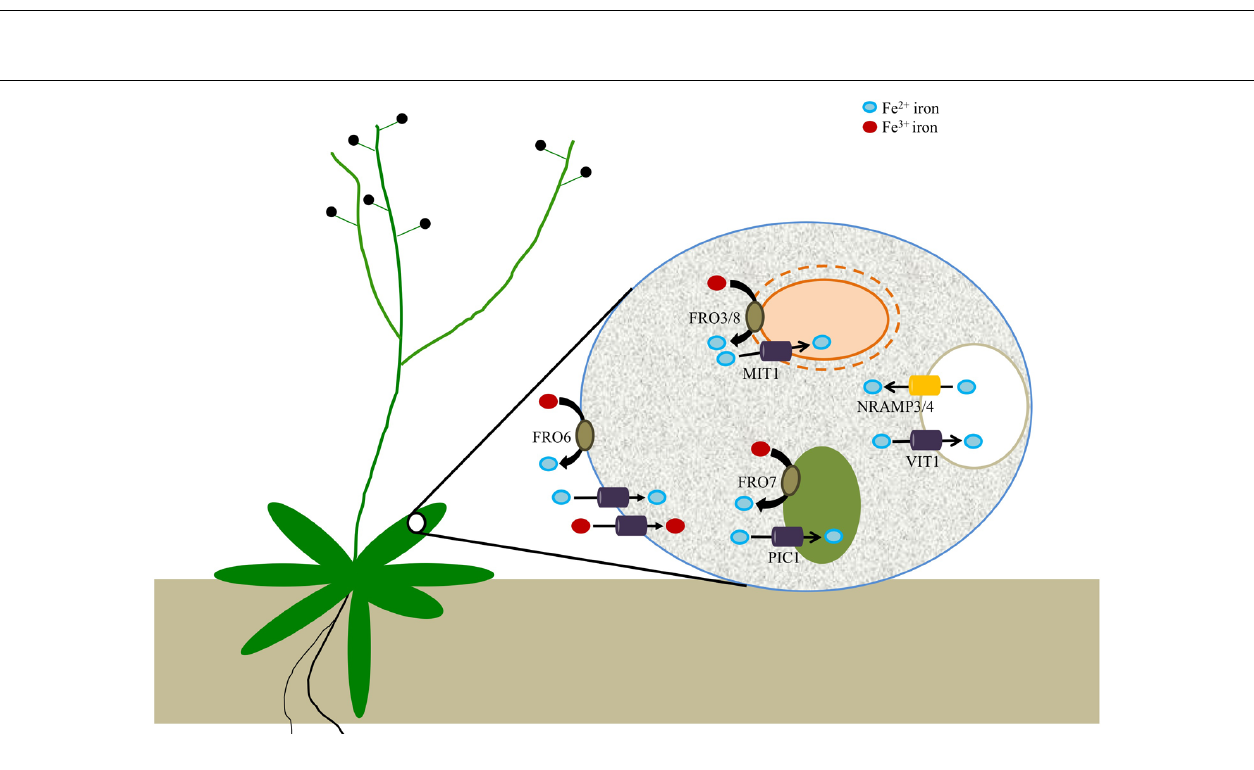
FIGURE 2 | Arabidopsis ferric reductases and transporters that contribute to cellular iron homeostasis. Evidence suggests that FRO6 functions to reduce Fe 3 + to Fe 2 + at the cell surface of leaf cells; Fe 2 + is subsequently transported across the membrane via an unknown transporter(s), while other unknown transporters may be involved in the uptake of Fe 3 + . Iron is then trafficked to a set of intracellular organelles.